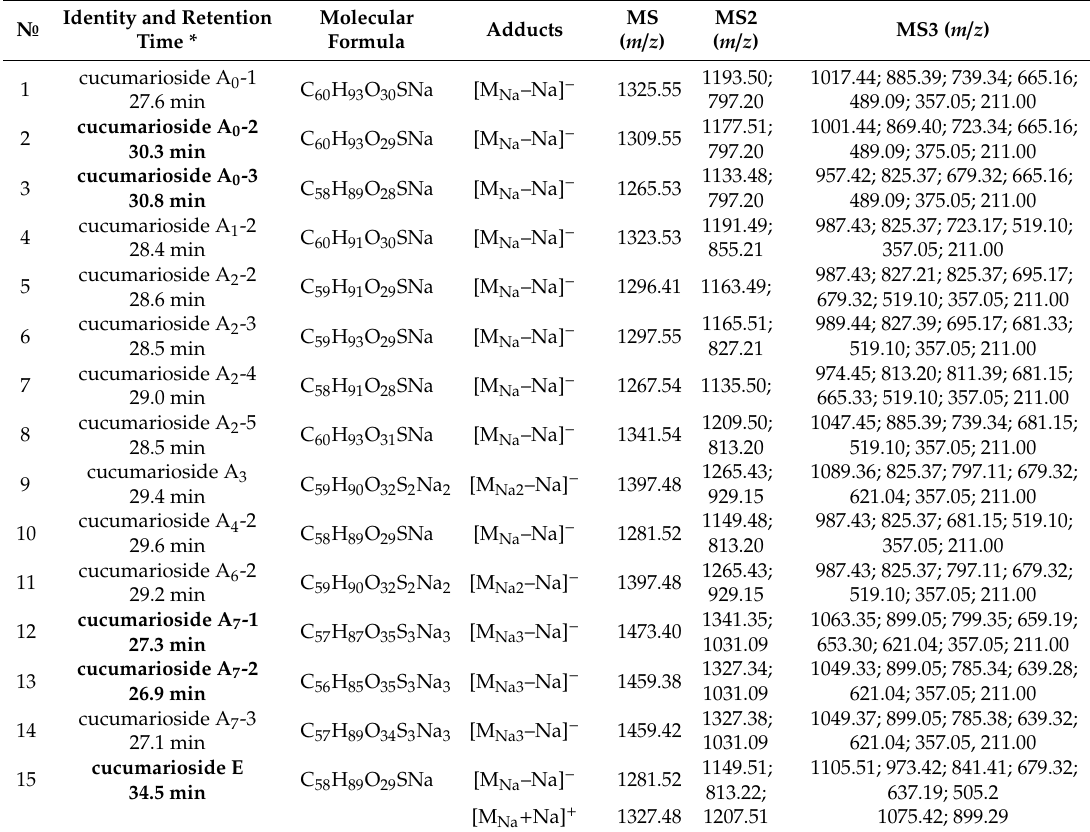
Table 3. Triterpene glycosides identified from the supercritical extract of C. frondosa japonica .